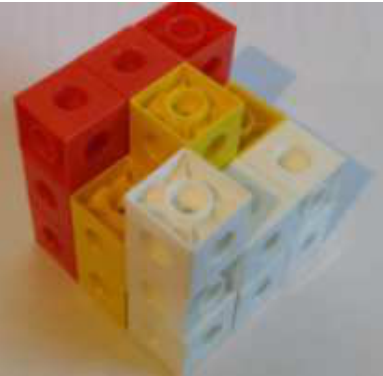
Fig. 4. Construction à reproduire.